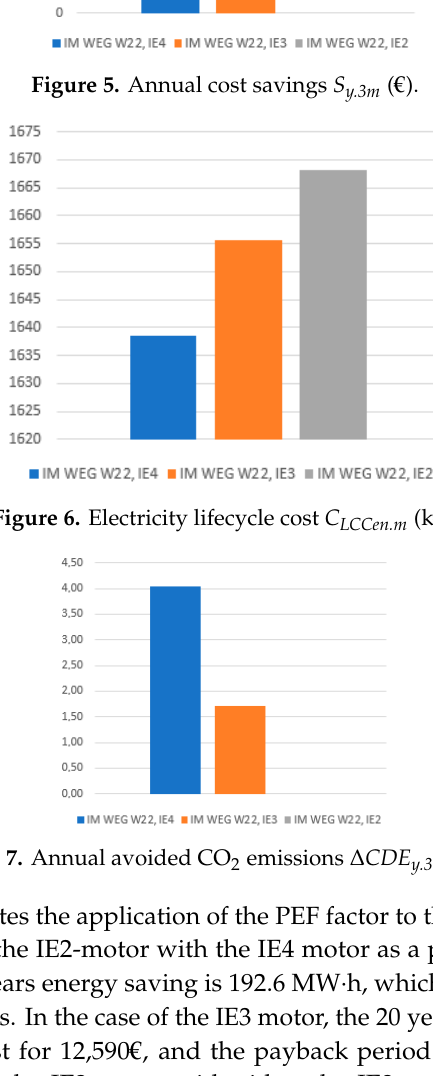
Table 5. CO 2 emissions calculation results.